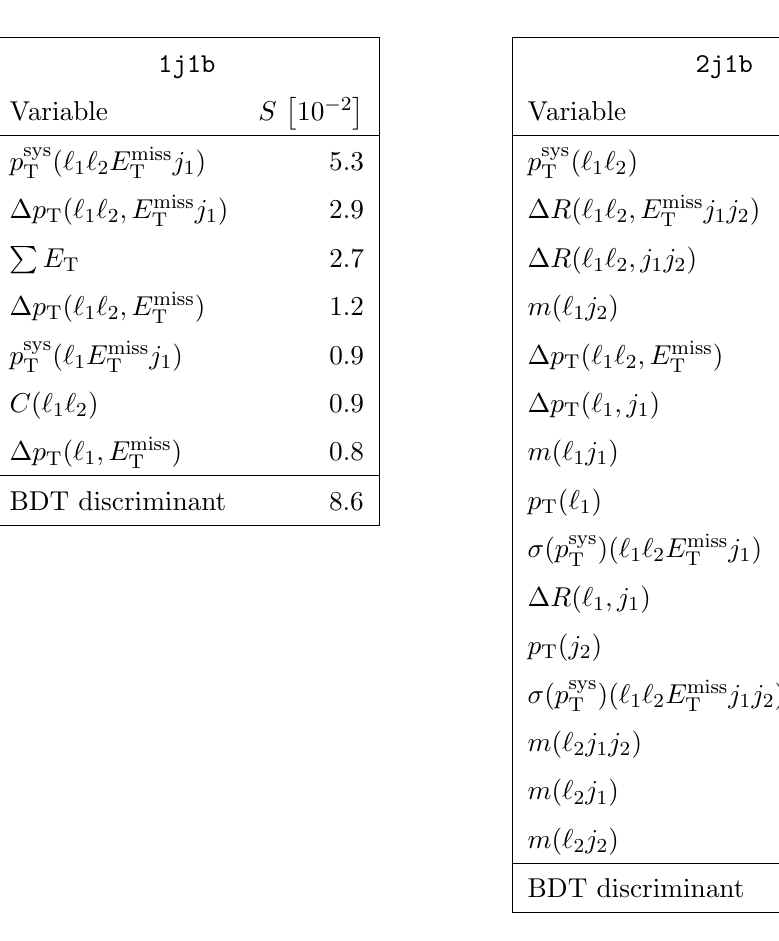
Table 2. The variables used in each BDT and their separating powers (a measure of the di(cid:11)erence between probability distributions of signal and background in the variable, denoted S ). The variables are derived from the four-momenta of the leading (sub-leading) lepton ‘ 1 ( ‘ 2 ), the leading (sub-leading) jet j 1 ( j 2 ) and E miss . The last row gives the separation power of the BDT T discriminant